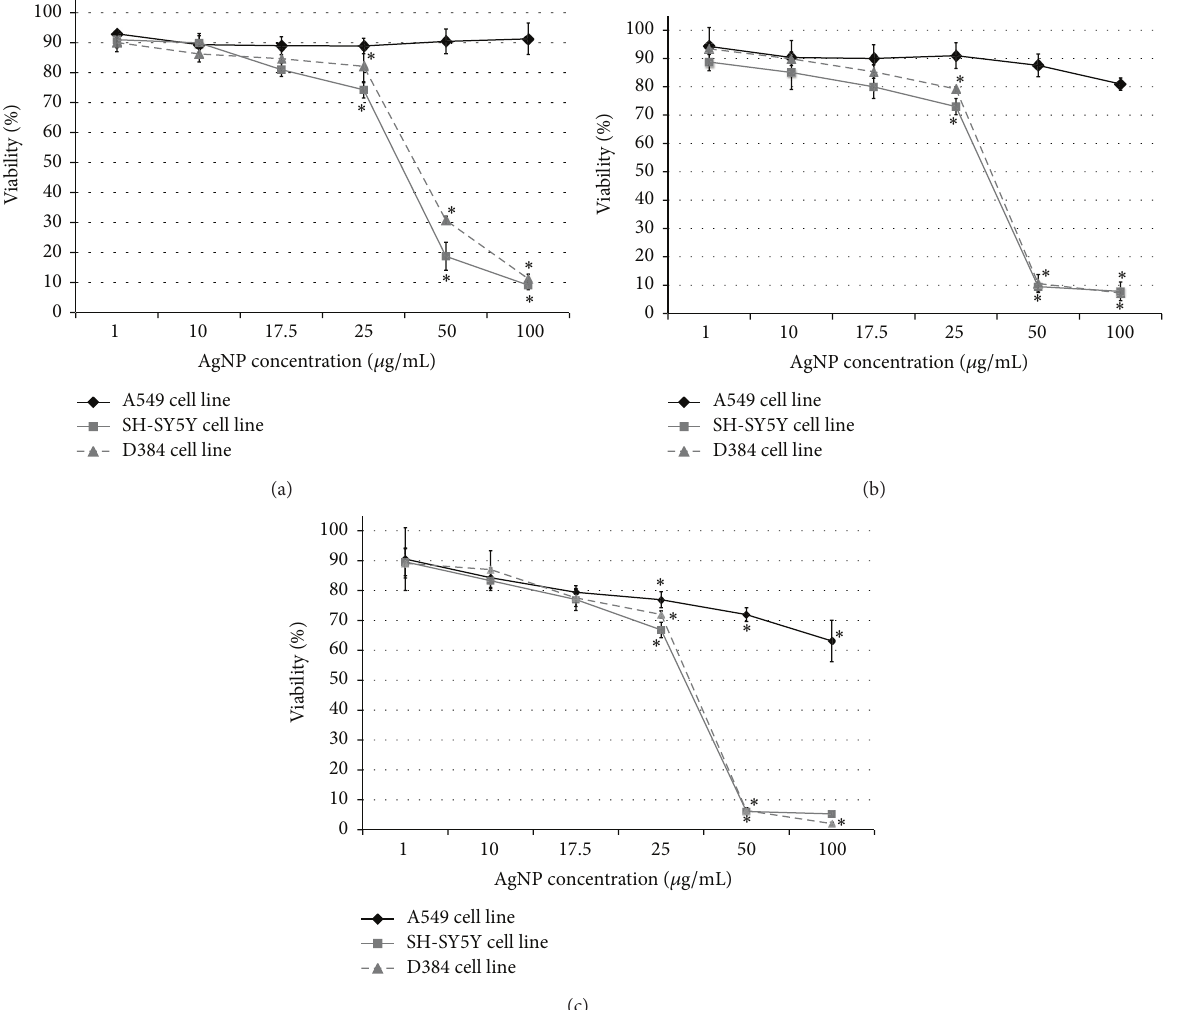
Figure 1: Mitochondrial function evaluation by MTT assay in SH-SY5Y, D384, and 549 cell lines. Evaluation of mitochondrial function in SH-SY5Y, D384, and A549 cell lines after 4 h (a), 24h (b), and 48 h (c) exposure to increasing concentrations (from 1 to 100 𝜇 g/mL) of AgNPs showed dose- and time-dependent changes in mitochondrial metabolism on both cerebral cell lines starting at the dose of 25 𝜇 g/mL and already after 4 h exposure. Pulmonary cells (A549) were less susceptible to AgNP exposure, showing a reduction of cell viability after 48 h exposure at the higher doses of AgNPs. ∗ Different from control in each cell line 𝑃 < 0.05 , Statistical analysis by ANOVA followed by Tukey’s test. Error bars indicate